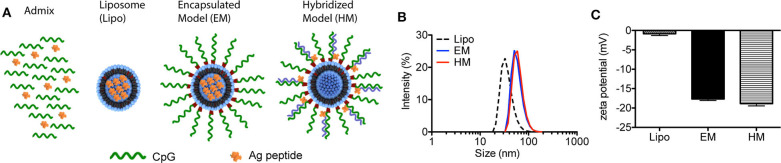
Characterization of IS-SNAs. (A) Diagram of Admix, liposomes, EM and HM IS-SNAs. (B) Dynamic light scattering analysis and (C) zeta potential of liposomes, EM IS-SNAs, and HM IS-SNAs.